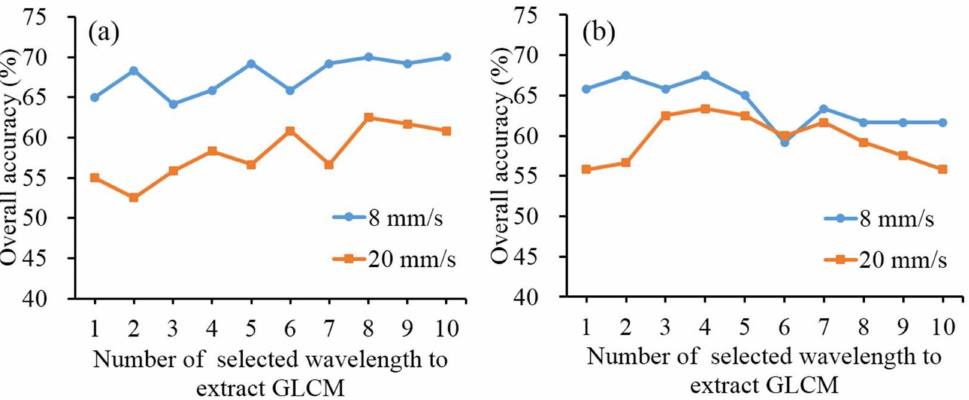
Figure 8. There-class performance comparison based on image textural features at different scanning speeds and spectral resolutions of 1.25 nm ( a ) and 5.03 nm ( b ), respectively.